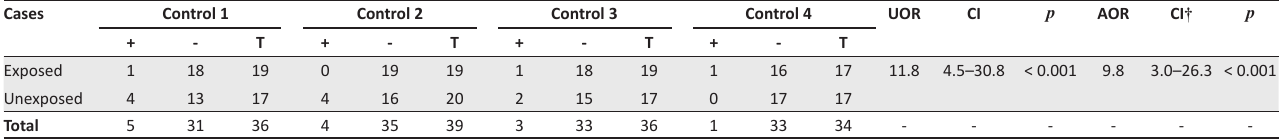
TABLE 3: Bivariable and multivariable analysis of non-disclosure of HIV-positive status among cases and controls.